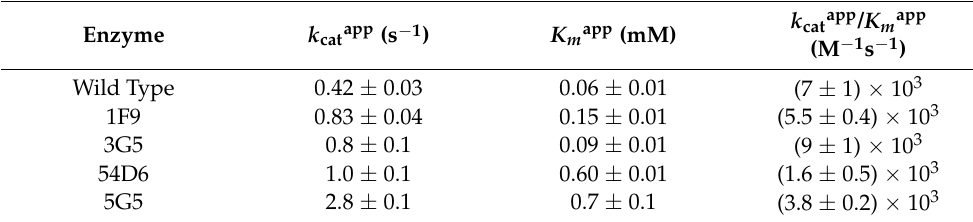
Table 3. Apparent steady-state kinetic parameters of wild type and variants for DMP, measured at 25 ◦ C in sodium phosphate buffer at pH 3.8 in the presence of 0.2 (wild type) and 0.6 mM (1F9,